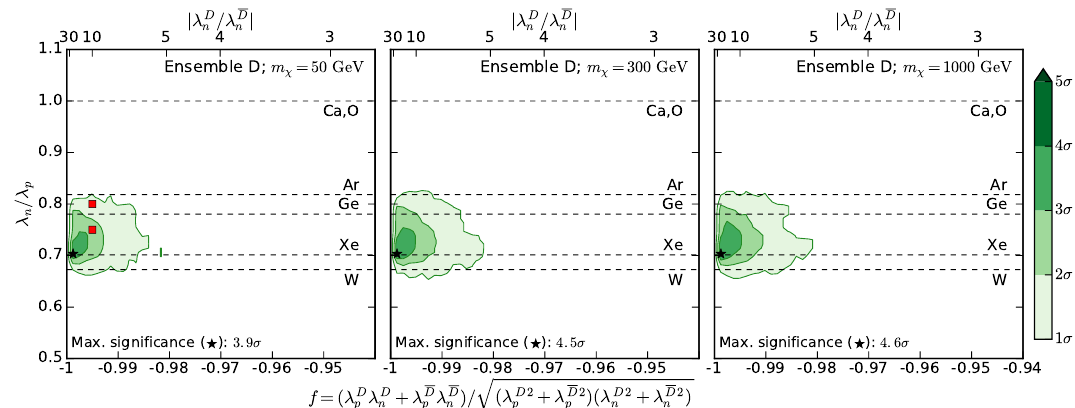
Figure 4 . Median signi(cid:12)cance for discriminating Dirac from Majorana DM using ensemble D (Xe + Ar + 50% Ge + 50% CaWO 4 ). As (cid:12)gure 1, but for ensemble D. The red squares in the left panel denote the parameter points which are examined further in (cid:12)gure 5.